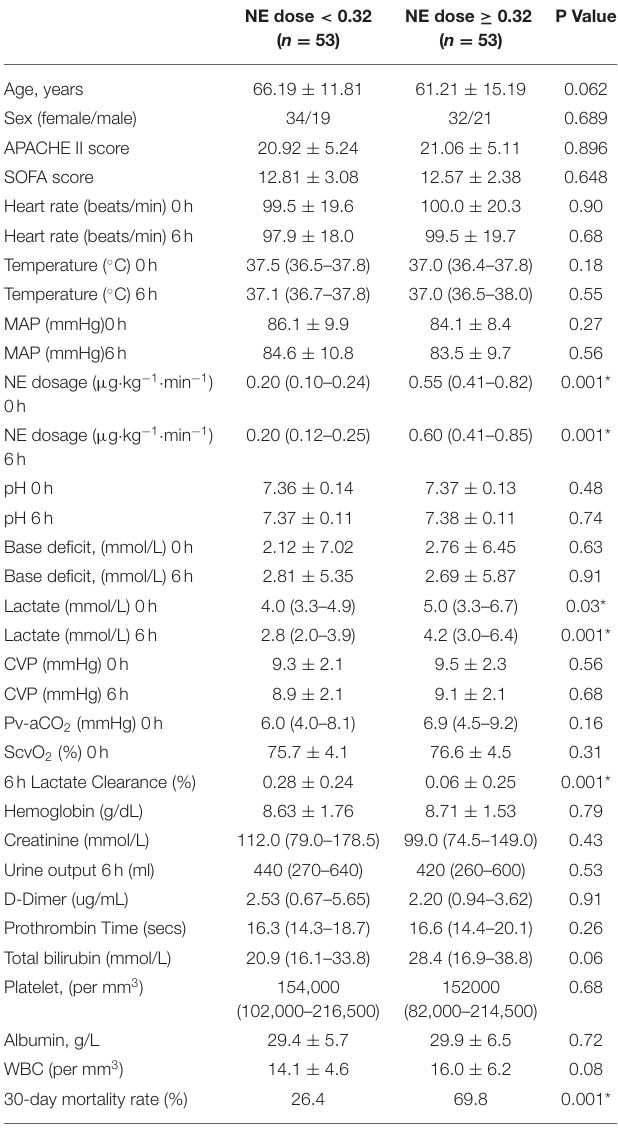
TABLE 4 | Baseline characteristics and outcome between low and high NE dose groups.